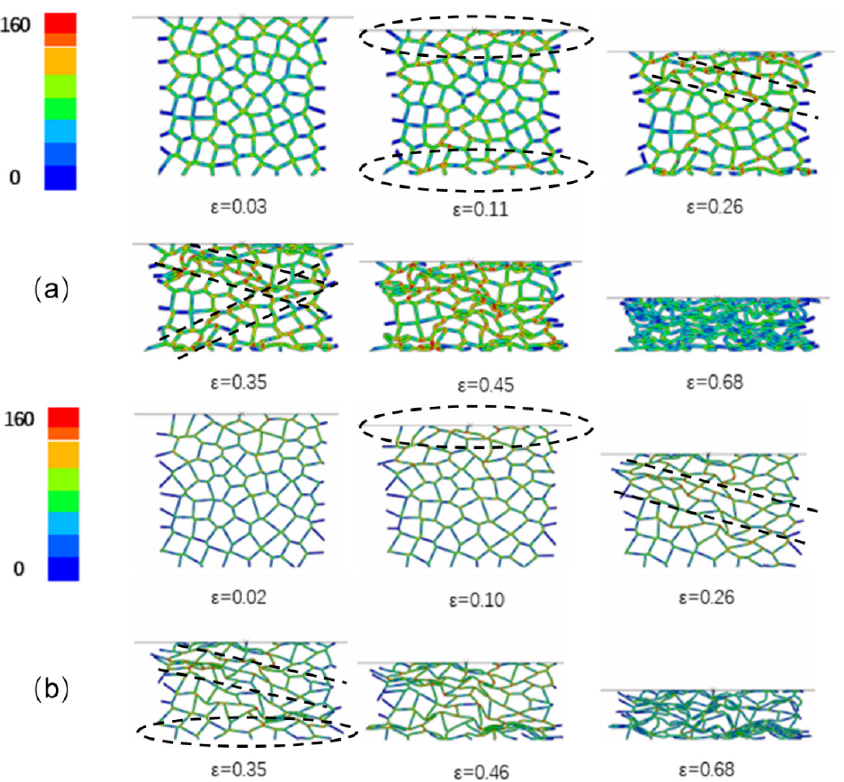
Figure 19. Deformation process of specimens with ( a ) 73.0% porosity and ( b ) 85.7% porosity under uniaxial impact (10 m/s).